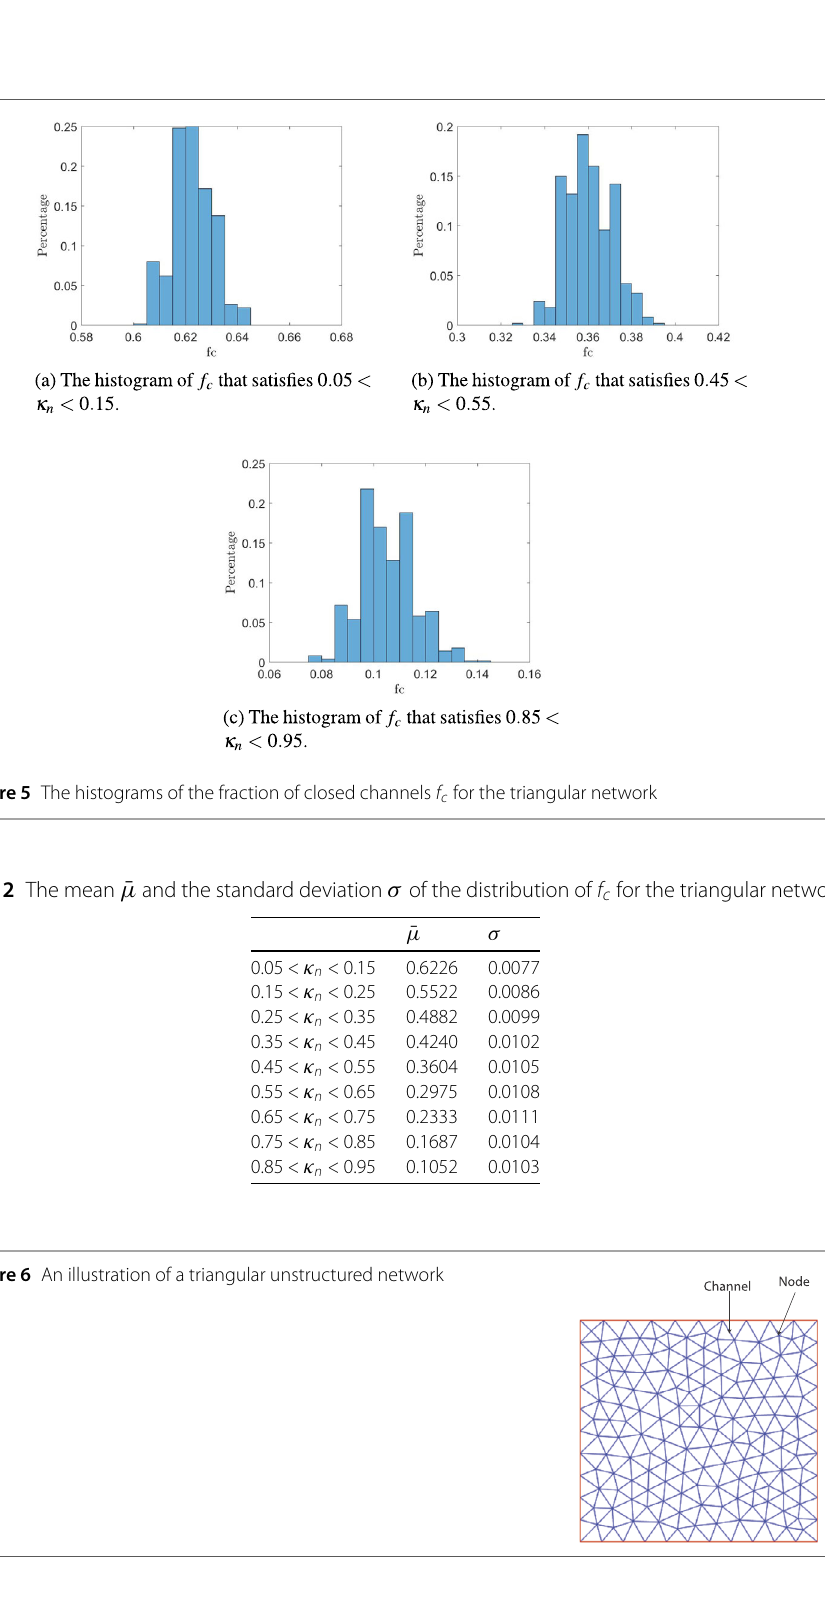
depends on the percolation threshold and hence on the network topology. The normalised permeabilities, for the different network topologies used in this paper and for the Kozeny– Carman equation, are depicted in Fig.